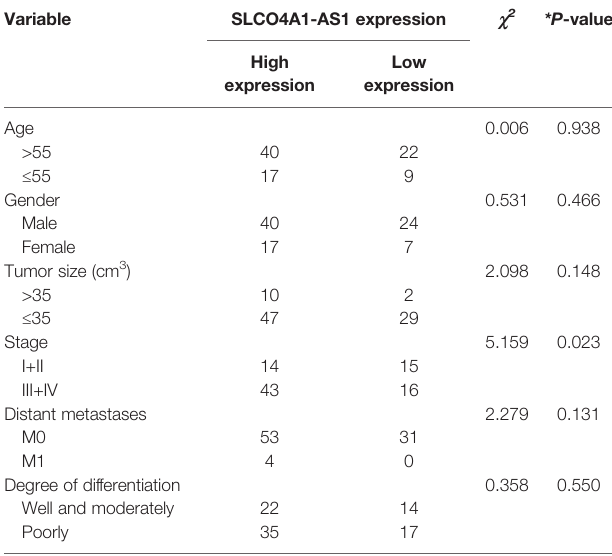
TABLE 1 | Correlative analysis of SLCO4A1-AS1 levels with different clinical features of gastric cancers.